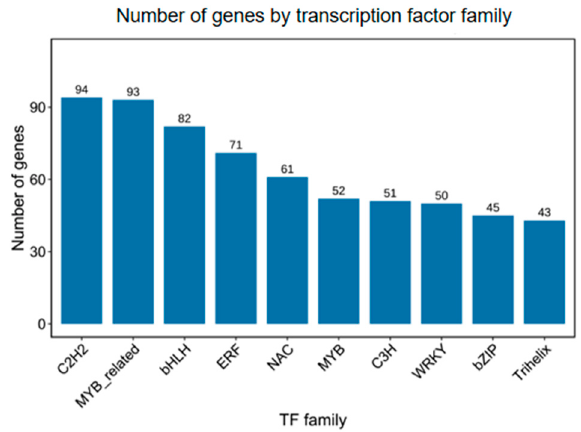
Figure 3. Transcription factor (TF) family statistics. The abscissa is the name of the transcription factor families, and the ordinate is the number of genes.